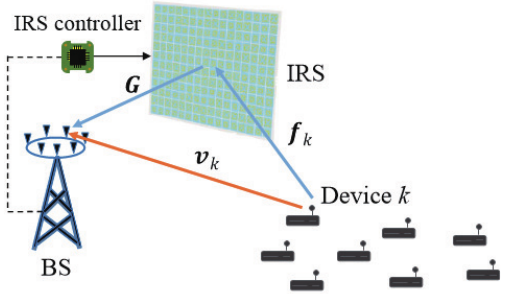
Figure 1. IRS-aided uplink consisting of a multiantenna BS, K single-antenna devices, and an IRS with N